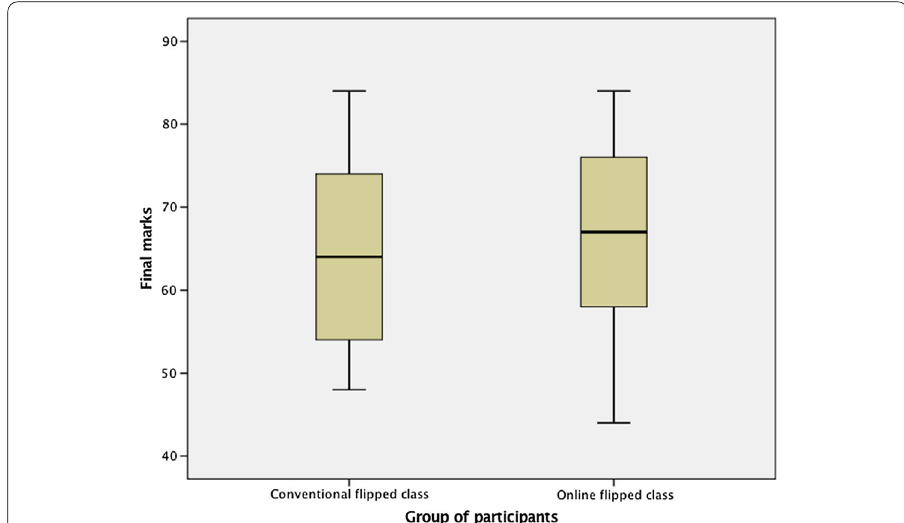
Fig. 8 The boxplots of final marks in Course 1 for conventional flipped class and online flipped